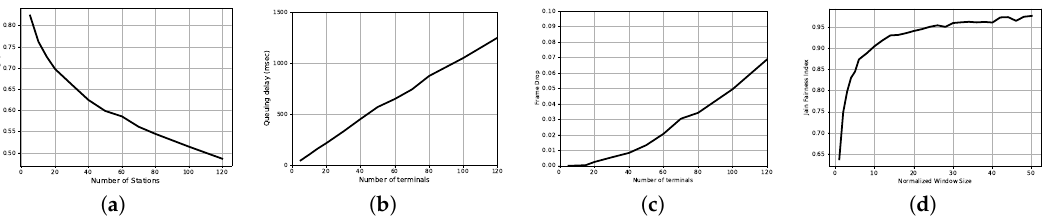
Figure 3. Comparison with Akeel’s work. ( a ) Saturation Throughput; ( b ) Access Delay; ( c ) Frame Drop Ratio; ( d ) Jain’s Fairness